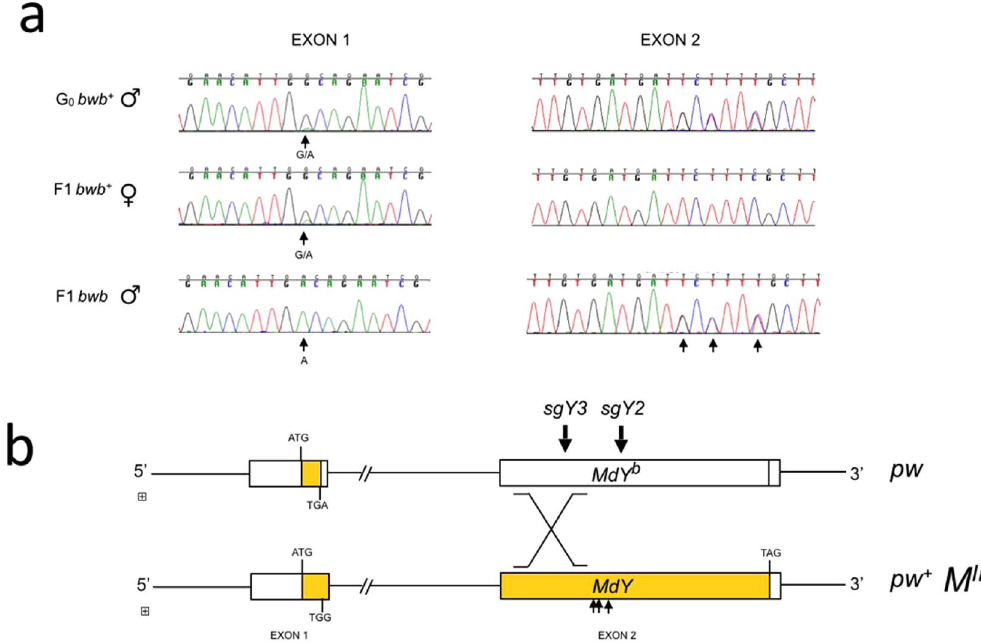
Figure 3. Intragenic recombination in line MdY#29 mediated by CRISPR/Cas9. ( a ) Excerpts of chromatograms of exon 1 and 2 showing allele-specific polymorphisms. Mutant F1 bwb males are homozygous for the two variants in exon 1 ( MdY b genotype) amplified with primers Y-ORF-F3 and RE1, but heterozygous for the three variants in exon 2 like in the paternal wildtype bwb G 0 male amplified with primers FE4 Y-ORF-R5. Arrows point to the allele-specific polymorphisms examined. ( b ) This sequence analysis suggests that an intragenic recombination occurred downstream of the MdY b specific TGA stop codon in exon 1 and upstream of polymorphisms examined in exon 2. Locations of the SNPs between the two target sites (sgY3 ad sgY2) are indicated with short